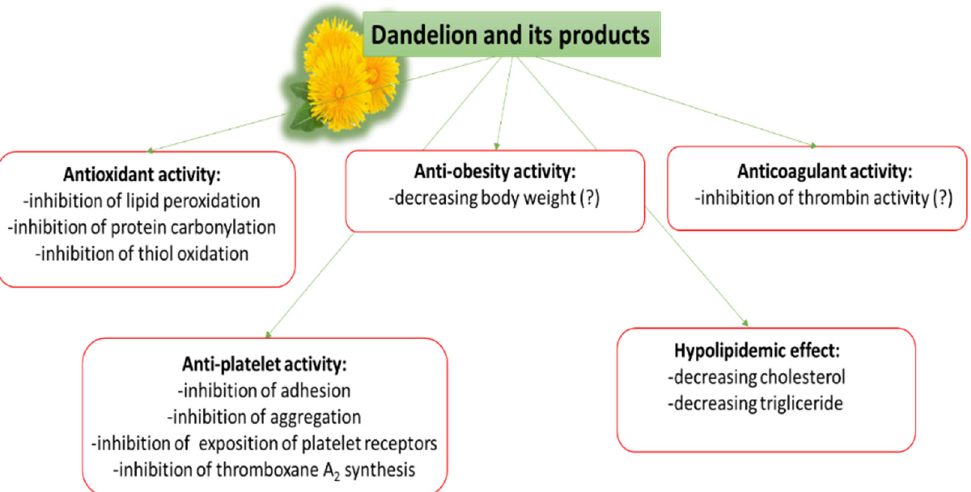
Figure 1. Multifunctional action of dandelion and its products on CVDs.